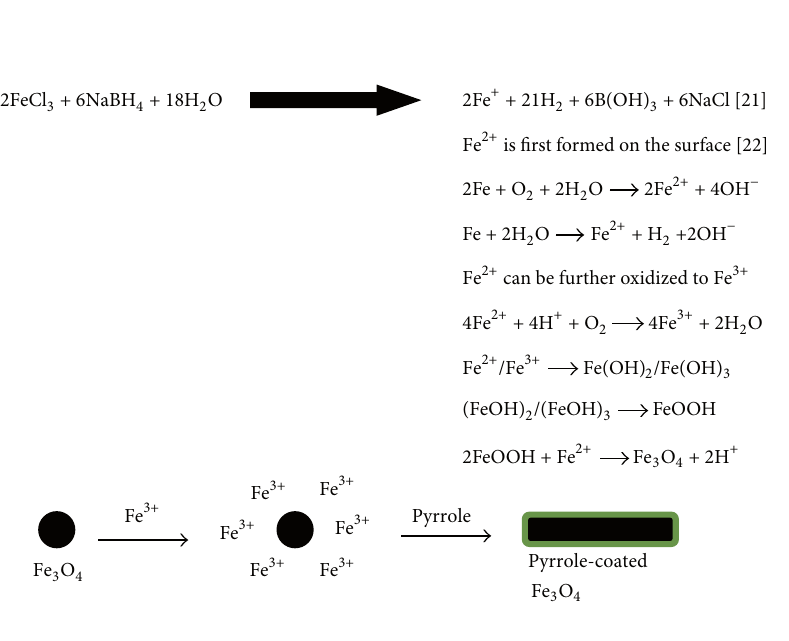
F 2: Schematic diagram of the formation processes of pyrrole-coated rod-shaped Fe